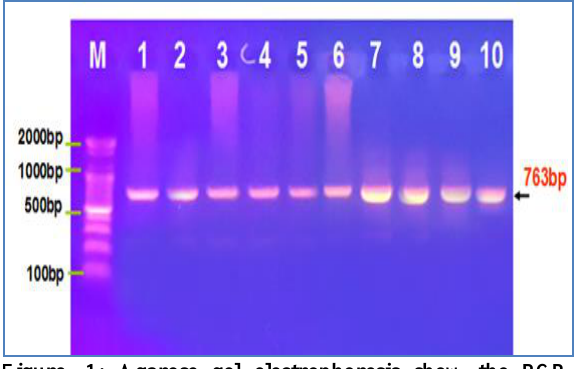
Figure, 1: Agarose gel electrophoresis show the PCR product analysis of 18S rRNA gene in cryptosporidium spp .